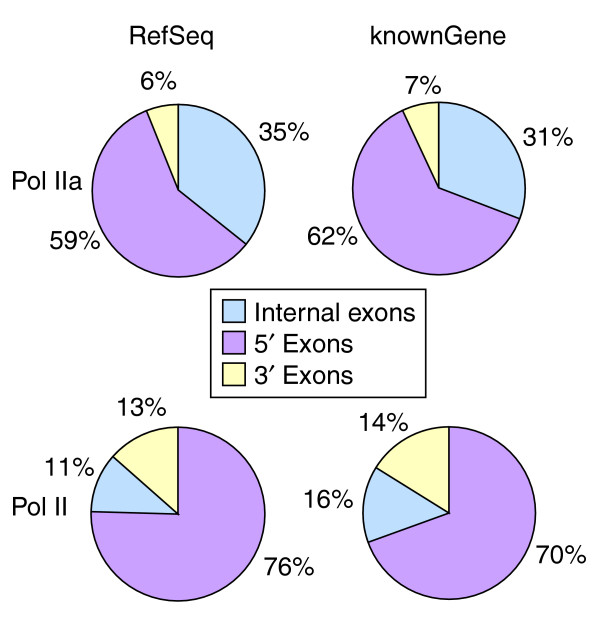
Different RNA polymerase states show distinct exon biases. Pie charts representing the percentage of exons in each category at RNA polymerase enrichment locations. These include exons from enrichment locations that include more than one exon. PolIIa is strongly biased towards transcription initiation locations. Most of the internal exons are second exons overlapping with first exons. The phosphorylation-independent antibody recognizes PolII at both transcription initiation and termination locations with a slight bias towards termination locations.